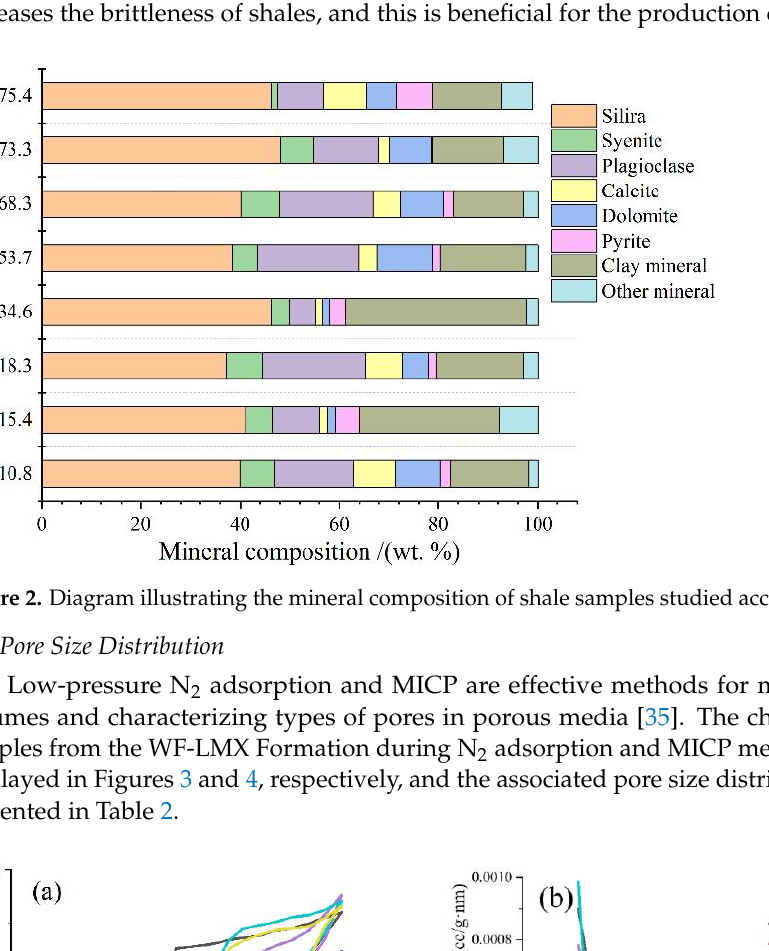
Figure 3. Plots illustrating ( a ) the low pressure N2 adsorption – desorption responses of the shales studied and ( b ) the pore size distribution of the samples.